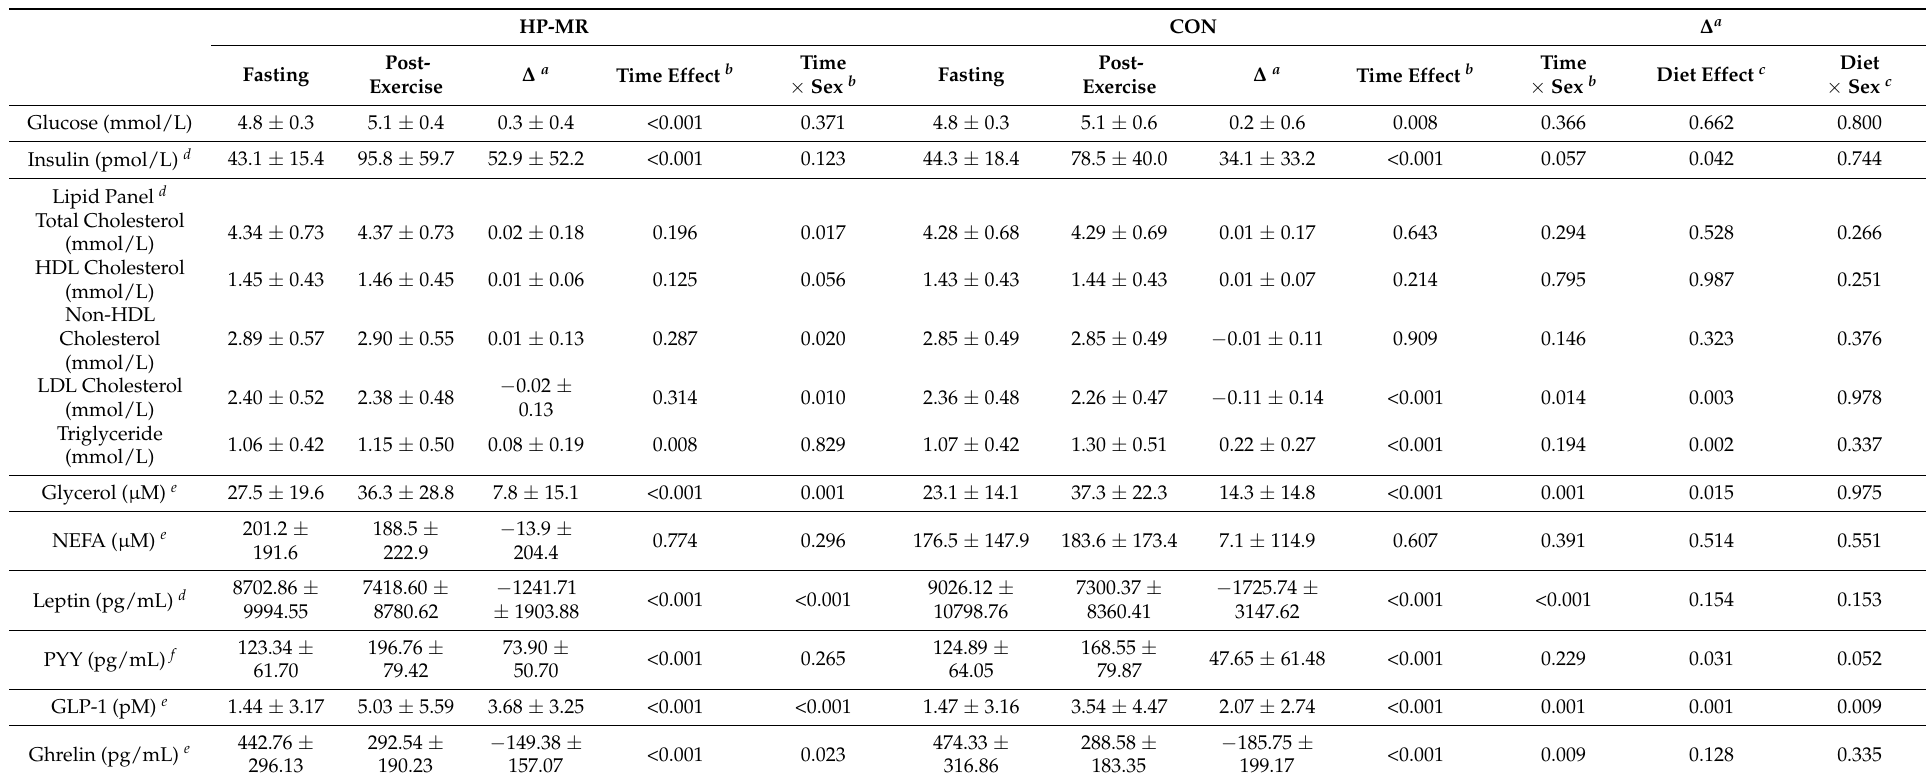
Table 3. Metabolic blood markers before and after the exercise